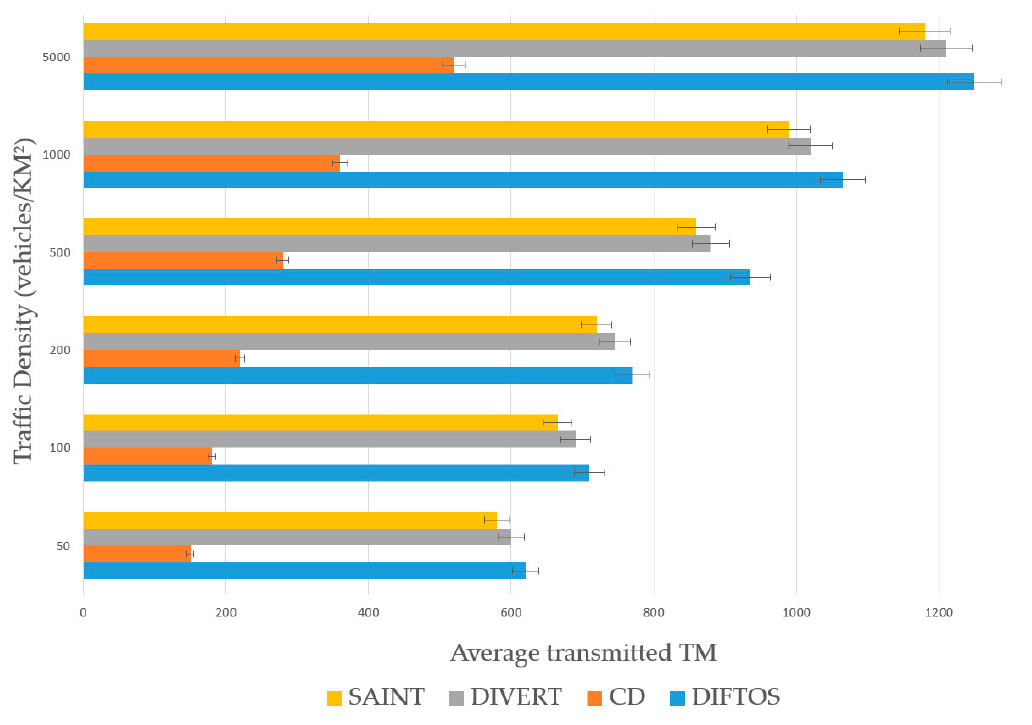
Figure 8. Traffic density vs. communication overhead.